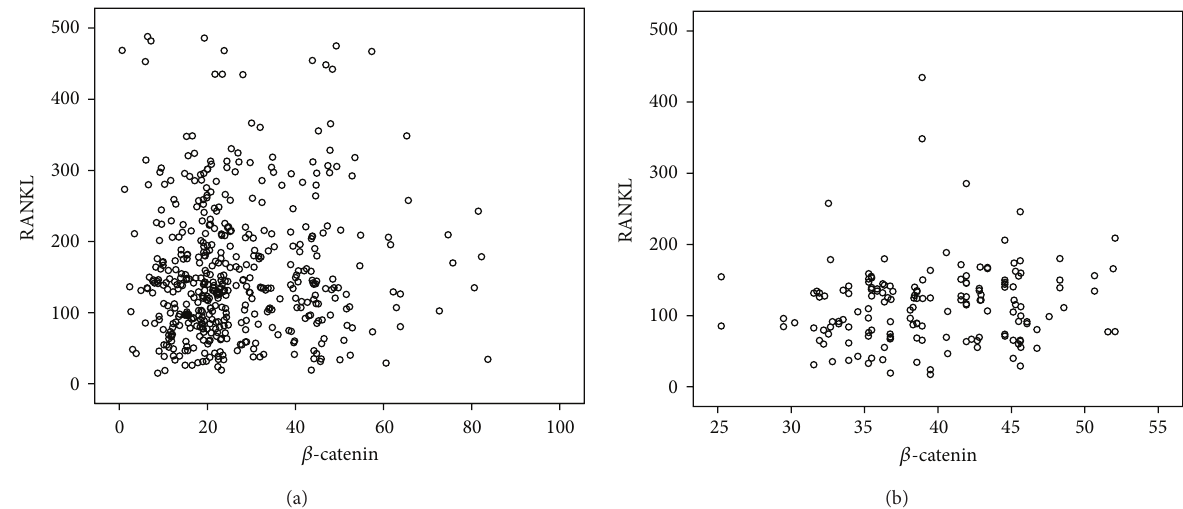
Figure 2: Univariate correlation (Spearman analysis) between 𝛽 -catenin and RANKL serum levels in PMOP patients ((a) 𝑟 = 0.067 , 𝑃 = 0.143 ) and controls ((b) 𝑟 = 0.134 , 𝑃 = 0.081 ).